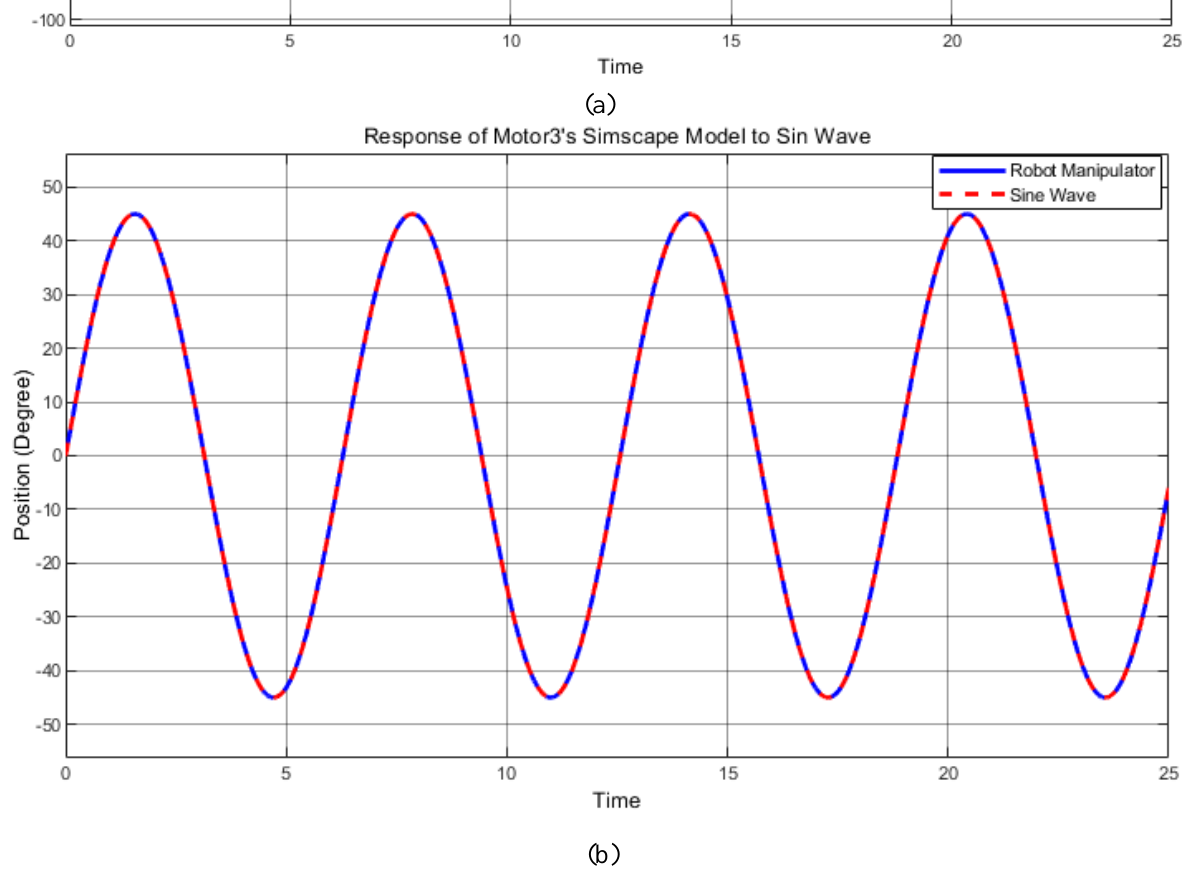
Figure 13. Joint 3 response a) step input, b) sinus